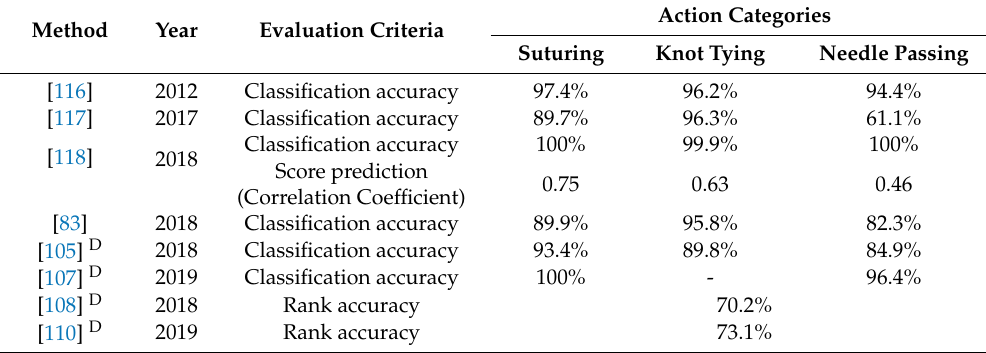
Table 6. Action evaluation performance of methods on the JIGSAWS dataset. The superscript D indicates a deep learning